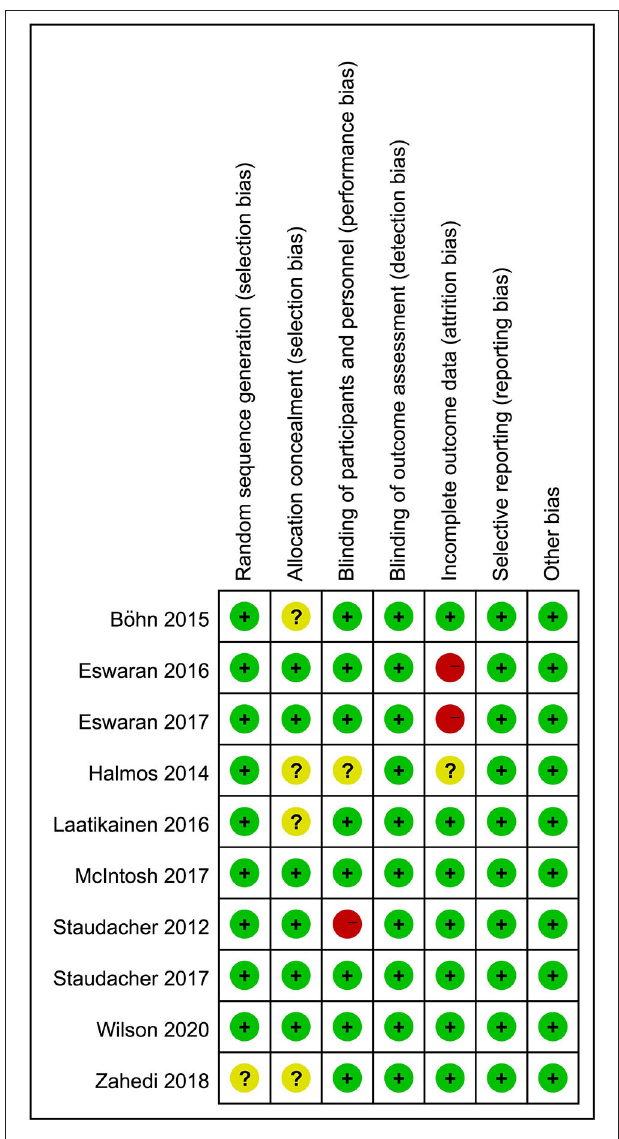
FIGURE 10 | Summary of risk of